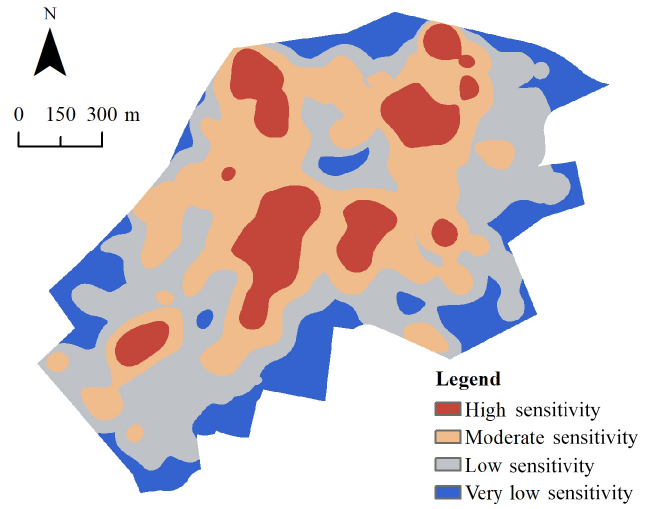
Figure 7. Classification and distribution of the number of potential user visual sensitivity.